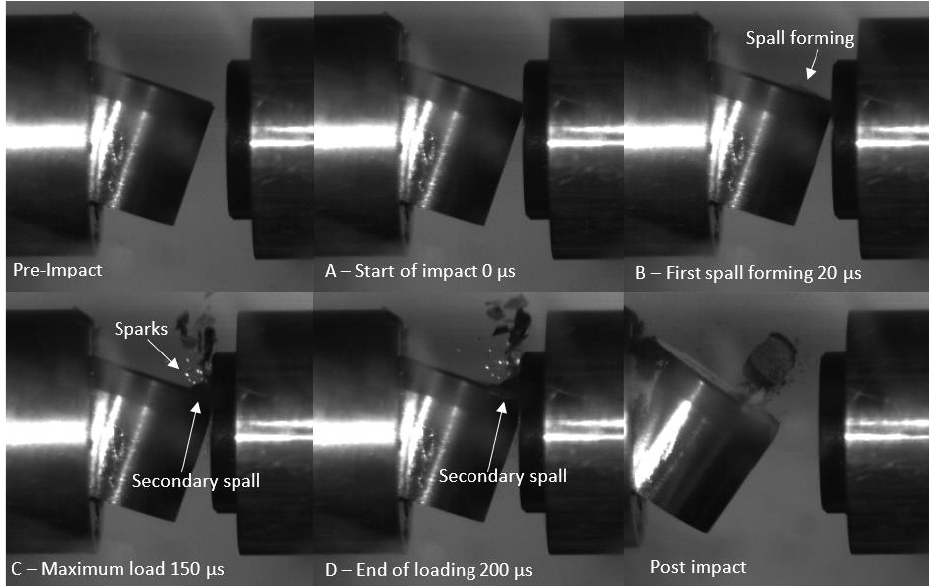
Fig. 5. Images taken during the impact of the cutter that failed